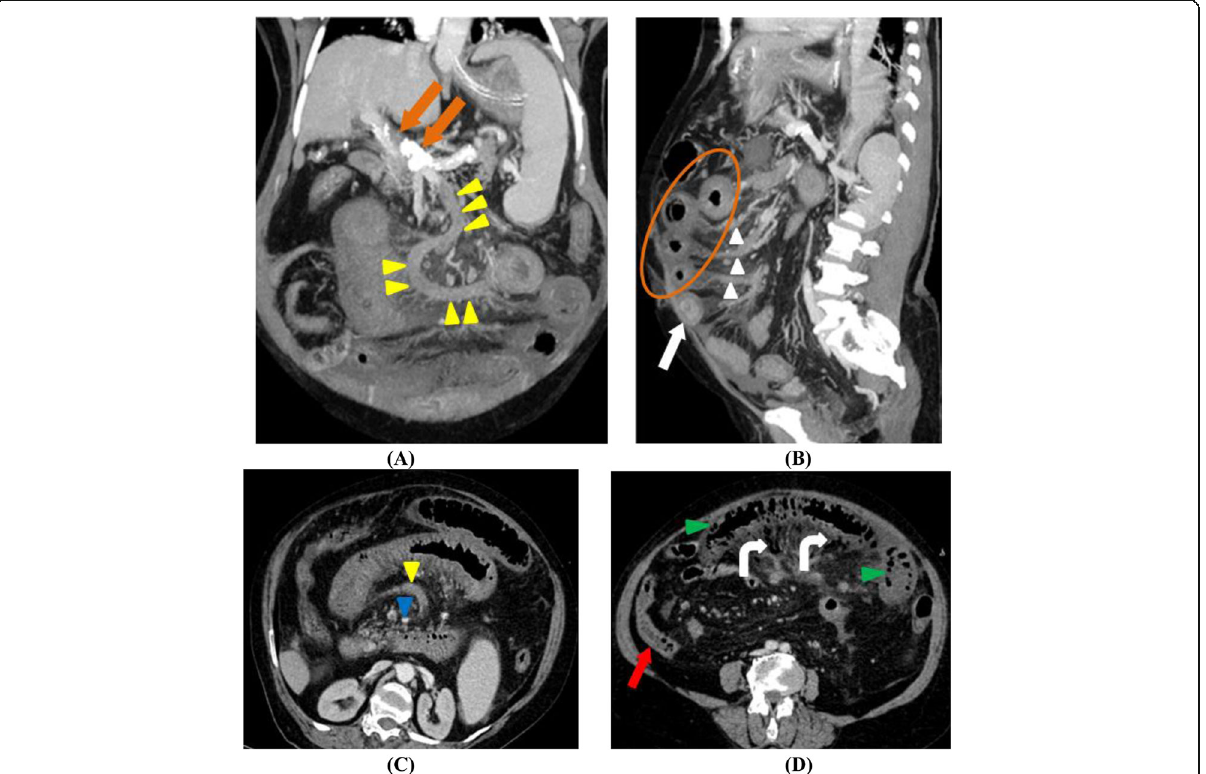
Fig. 15 A 65-year-old female patient presented with acute abdominal pain. a Coronal, b sagittal maximum intensity projection (MIP) CT images, showing partially thrombosed portal vein yet with good contrast opacification with old calcified thrombus seen within (orange arrows) with total thrombosis of the SMV (yellow arrowheads) (which has malrotation configuration with SMA (blue arrowhead) seen on ( c ) axial CT image) as well as its visualized distal branches (white arrowheads) and submucosal edema with non-enhancing affected bowel loops (circle) and hypoenhancing bowel loops (white arrow), giving a target sign. d Axial CT image showing non-enhancing distended bowel loops with diffuse pneumatosis intestinalis (green arrow heads), compared with normal enhancing ileal bowel loop (red arrow) with mesenteric venous gas is seen (curved arrows)